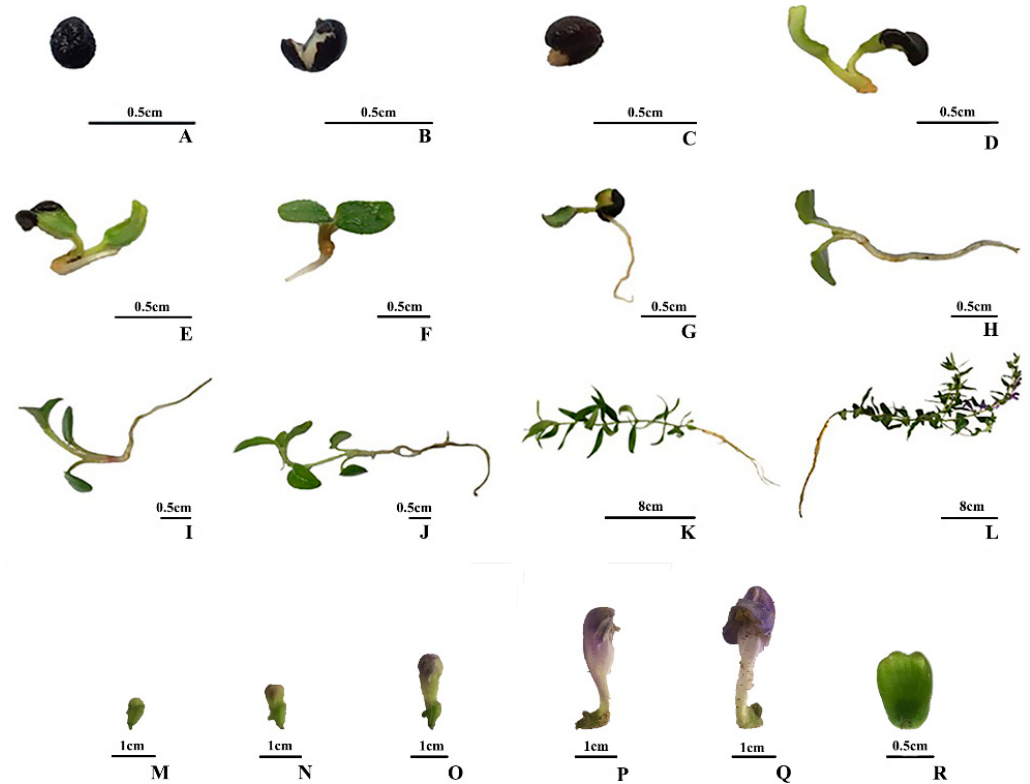
Figure 1. Samples collected at different growth stages. ( A ): sample collected at the beginning of sowing (day 0); ( B ): sample collected at the second day (day 2); ( C ): sample collected at the fourth day (day 4); ( D ): sample collected at the 6th day (day 6); ( E ) sample collected at the 8th day (day 8); ( F ): sample collected at the 10th day (day 10); ( G ): sample collected at the 12th day (day 12); ( H ): sample collected at the 14th day (day 14); ( I ): sample collected at the 18th day (day 18); ( J ): sample collected at the 22th day (day 22); ( K ): sample collected at the 62th day (day 62); ( L ): sample collected at the 83th day (day 83); ( M ): flower bud 1 (FB1); ( N ): flower bud 2 (FB2); ( O ): flower bud 3 (FB3); ( P ): flower bud 4 (FB4); ( Q ): flower (FL); ( R ): fruit (FR).